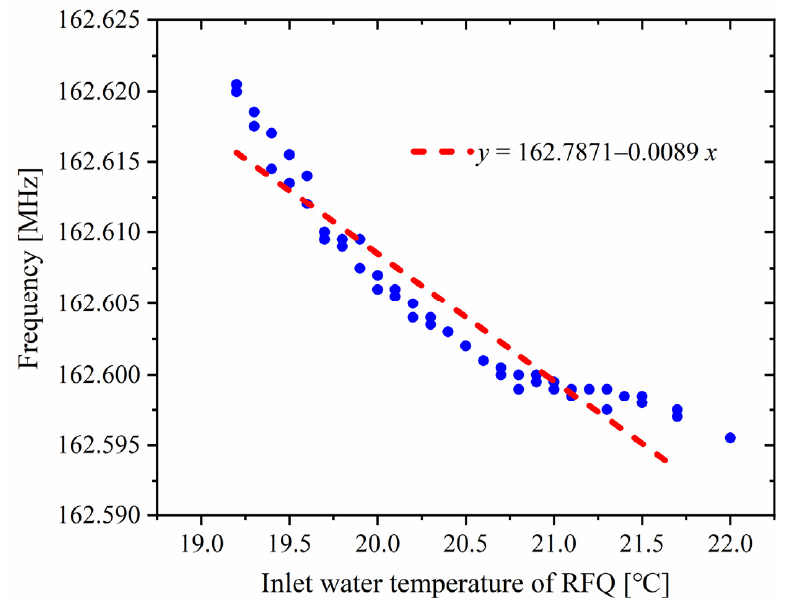
Figure 7. The log of a 6-h long operation without a trip.